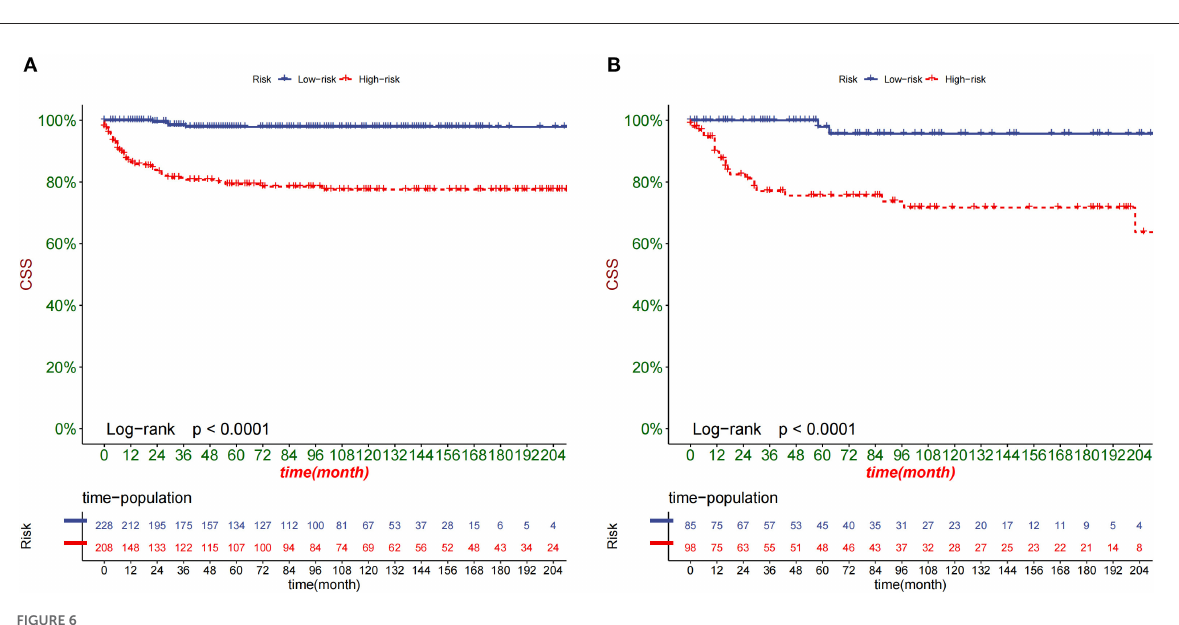
FIGURE6 Kaplan-Meier curves of children in the low-risk and high-risk groups in the training set (A) and validation set (B)